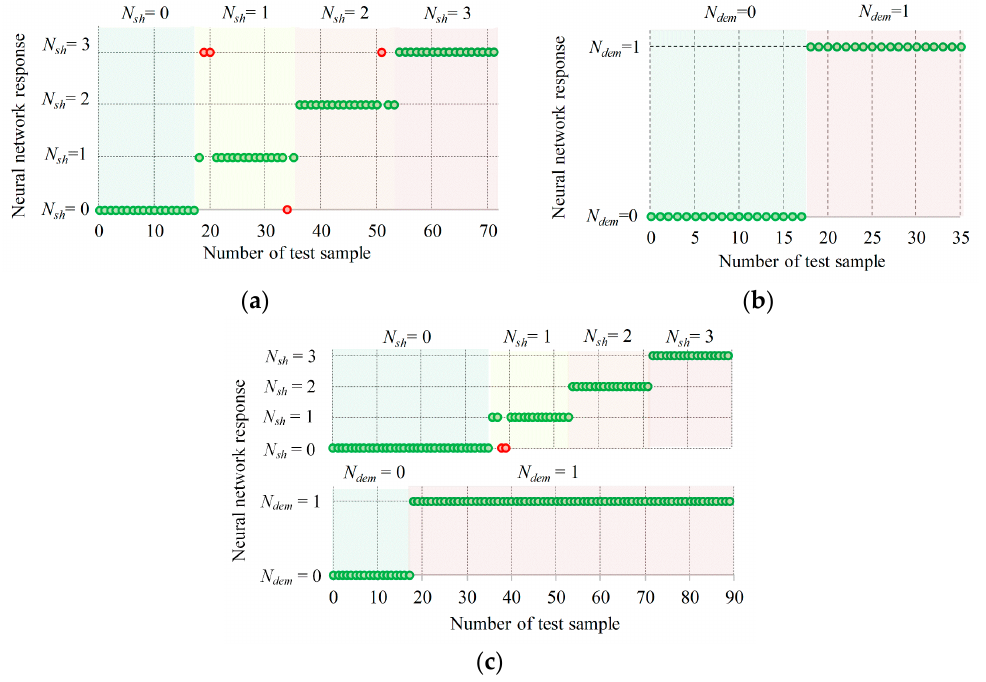
Figure 5. Experimental verification of the MLP-based fault detector of the PMSM motor: ( a ) inter- turn short-circuits; ( b ) permanent magnet fault; ( c ) mixed damage: N sh — number of shorted turns, N dem — permanent magnet technical condition (0 — unfaulty, 1 — partial demagnetization).